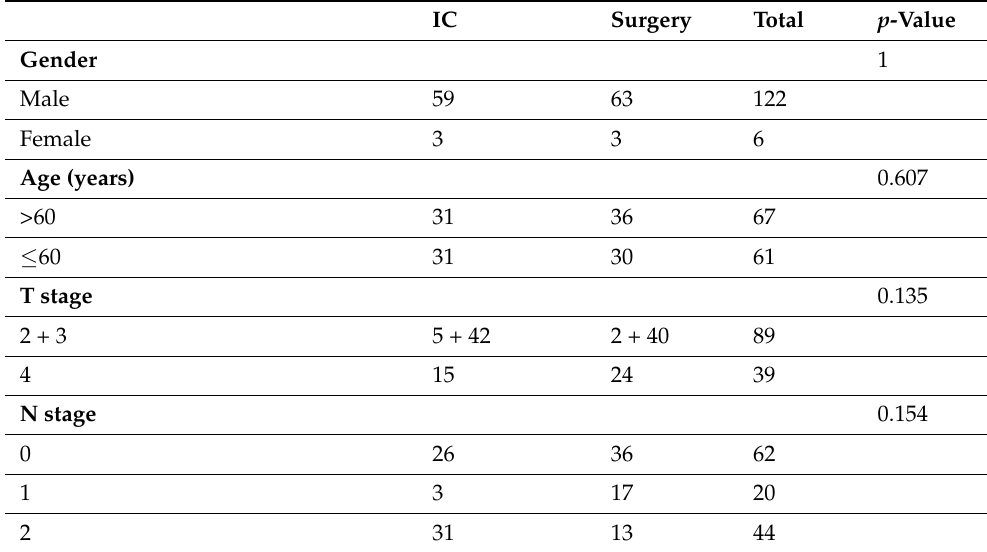
Table 1. Characteristics of laryngeal squamous cell carcinoma (LSCC) patients in the induction chemotherapy (IC) and surgery